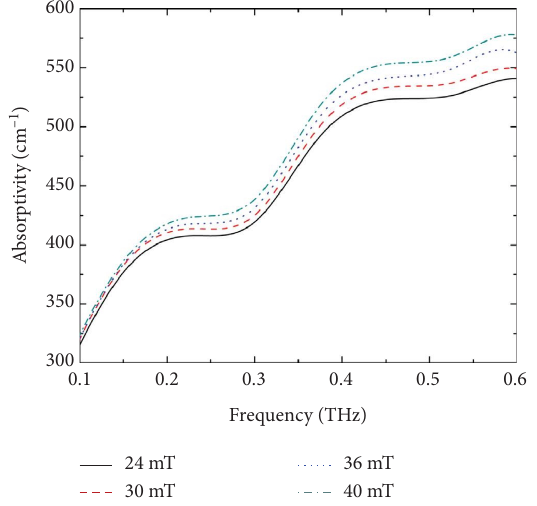
Figure 12: THz absorption spectra of MWCNTaqueous dispersion under diferent MF intensities.